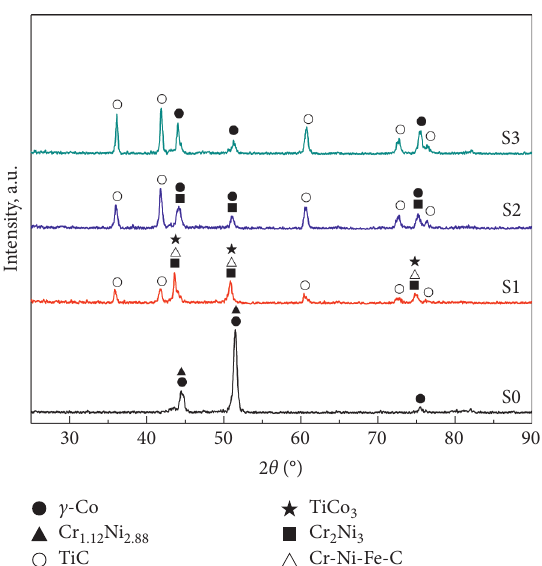
Figure 2: XRD spectrum of S0, S1, S2, and S3